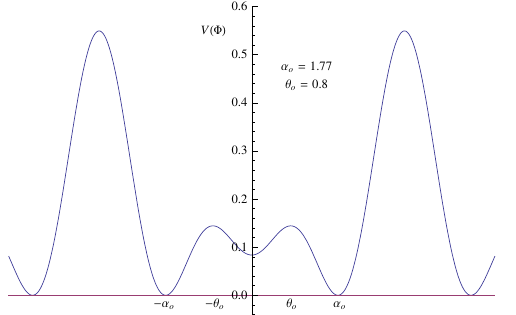
(Φ) in (3.68) for A 3 = − 0 . 1 , z = 0 . 2 , β = 1 , θ 0 = 0 . 8 and vacua 2